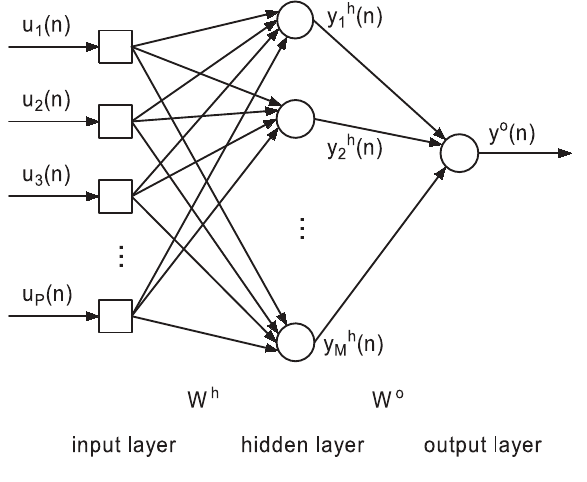
Figure 1. Structure of the feedforward neural networks.